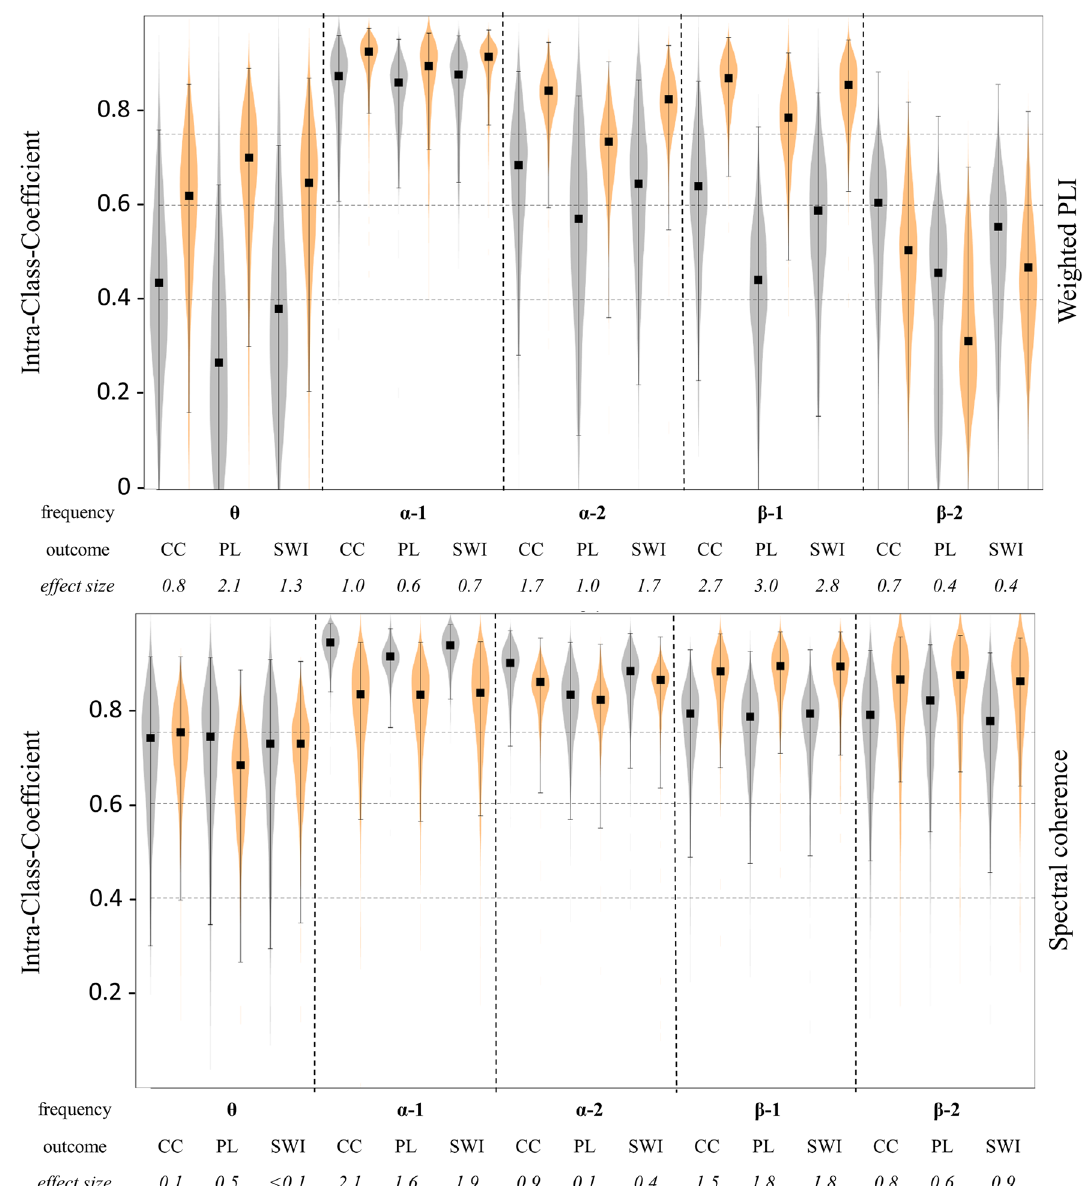
Figure 2. Violin plots of Intraclass-Correlation-Coefficient (ICC) values for graph measures based on weighted PLI (upper graph) and spectral coherence (lower graph) functional connectivity estimation. Measures were obtained from two experimental sessions within one week investigating EEG resting states before (PRE, grey violins) and after (POST, orange violins) an acute bout of 10 min of moderate-intensity running on the treadmill. Violins display the distribution of ICC values based on a resampling of k = 1000 iterations using the bootes function (Di Plinio 2020). For each pair of distributions (PRE vs. POST), effect size Cohen’s d was computed based on k ICC values per condition. Black squares indicate the ICC values of the original sample, brackets indicate the 95% confidence intervals. CC clustering coefficient, PL characteristic path length, SWI small-world index. Graph measures are computed for theta (θ, 4 to 8 Hz), alpha-1 (α-1, 8 to 10.5 Hz) and alpha-2 (α-2, 10.5 to 13 Hz), beta-1 (β-1, 13 to 20 Hz) and beta-2 (β-2, 20 to 30 Hz) frequency bands . Horizontal lines indicate thresholds for fair (0.4, lower line), good (0.6, midline) and excellent (0.75, upper line) ICC